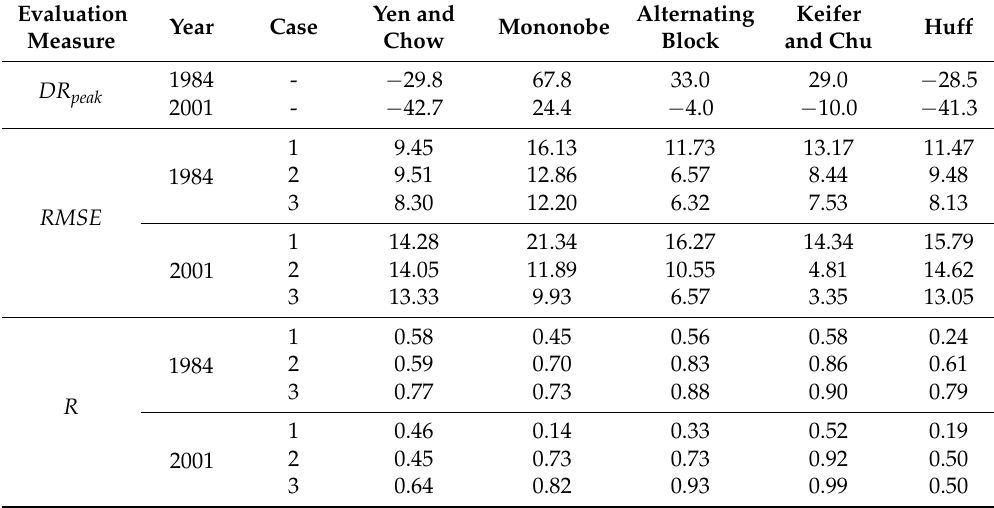
Table 2. Evaluation results of rainfall temporal distribution models with the maximum rainfall events observed in 1984 and